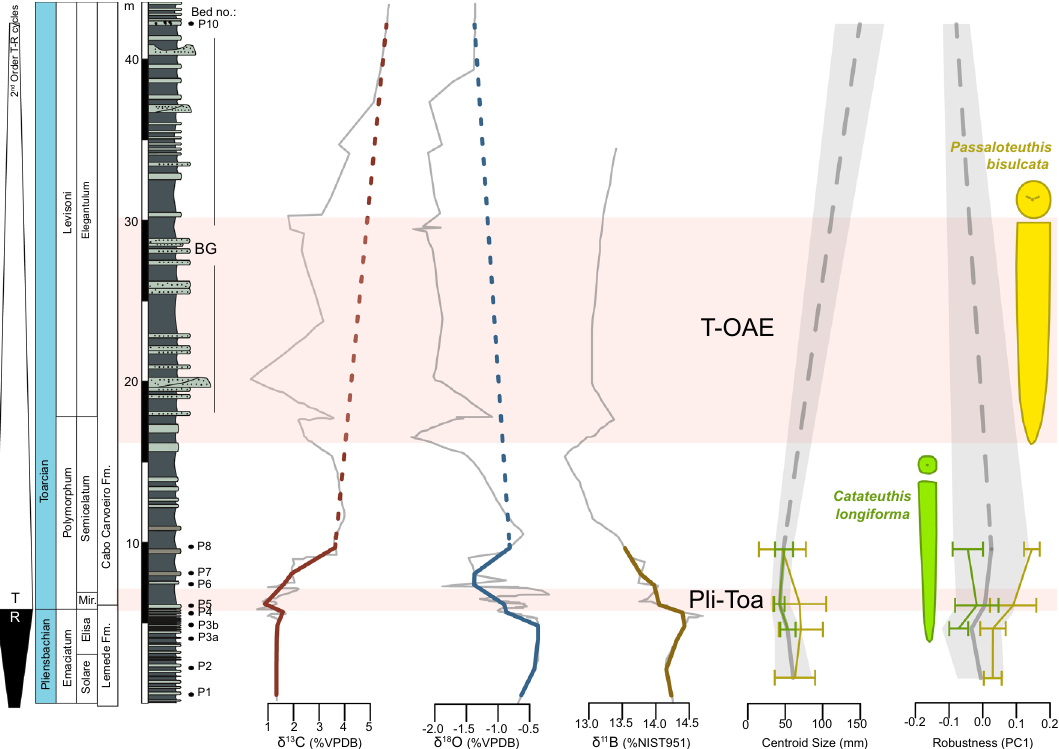
Figure 1. Palaeoenvironmental proxies in the Peniche GSSP section fluctuate across two hyperthermal pulses during the Pliensbachian-Toarcian crisis (PToB and T-OAE). The proxies from left to right are: 2nd order transgressive–regressive cycles to visualise changing bathymetry 87 , δ 13 C as a proxy for carbon cycle disturbances 42 , δ 18 O as palaeotemperature proxy 42 , and δ 11 B as a proxy for ocean acidification 42 . The grey lines in the background of the isotope curves show the original values 42 , whereas the thicker lines overlaying them represent the lower-resolution curves with data points only at the positions of the stratigraphic beds sampled in this study (see stratigraphic log on the left). The second-to-right curves show median GPA Centroid size as a body size proxy (grey line shows full assemblage pattern, with shaded area representing median absolute deviation (MAD), C. longiforma and P. bisulcata are shown in green and yellow, respectively, with error bars representing MAD). On the right-hand-side PC1 is displayed as proxy for robustness in purple (for colouration see Centroid Size description). The two belemnite shapes bracketing the robustness curves show typical cross section appearances for C. longiforma (in green on the left) and P. bisulcata (in yellow on the